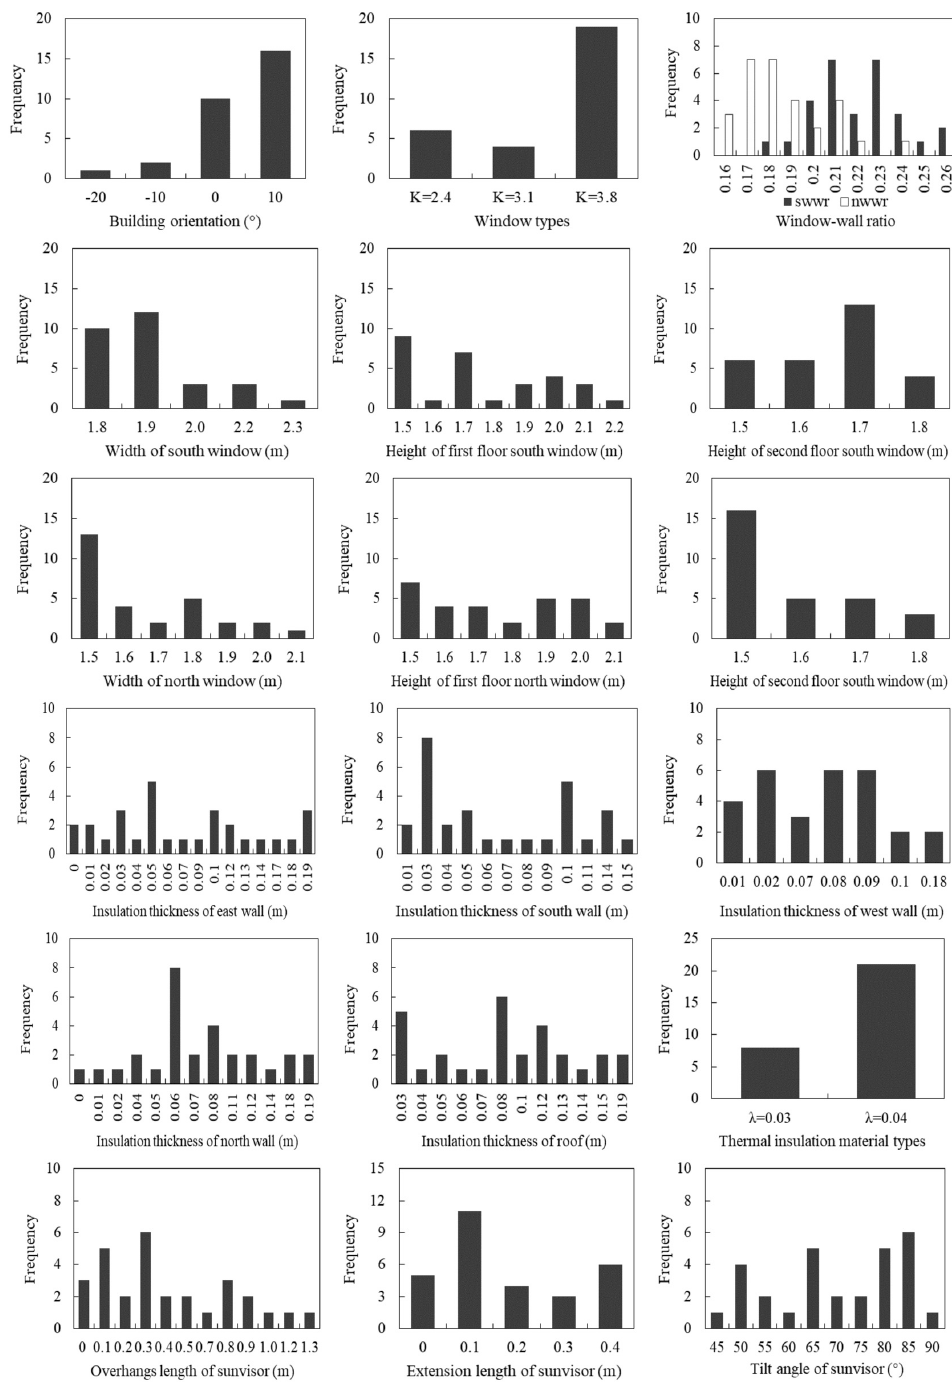
Figure 20. Value distributions for all design